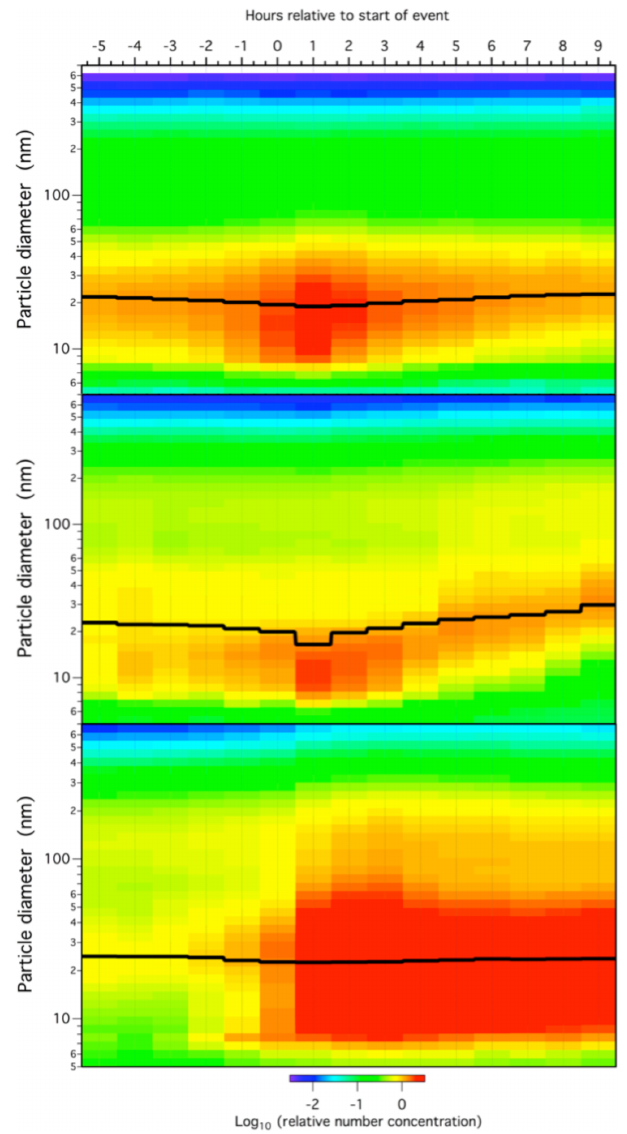
Figure 4. Average temporal development of the relative number– size distribution before and during NPF events identified by the three approaches. Relative number concentrations are formed by di- viding absolute number concentrations by the average total number during the 6h pre-event time periods. The black curve gives the me- dian sub-50nm particle diameter D 50 during the events. Top: PCT events; center: DGR events; bottom: MEV events.